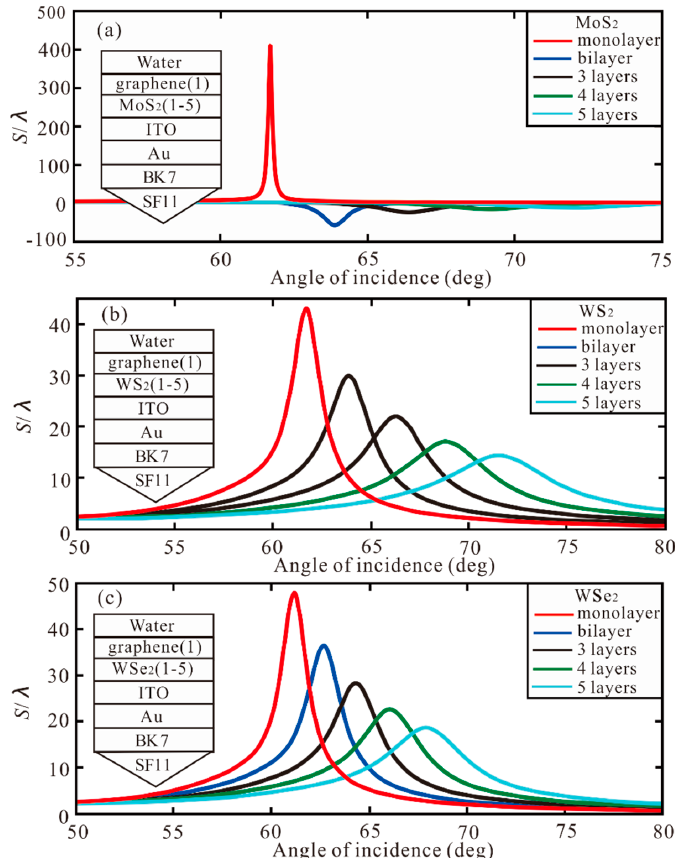
Figure 7. The GH shift with respect to angle of incidence with monolayer of graphene for different number of ( a ) MoS 2 layers, ( b ) WS 2 layers, ( c ) WSe 2 layers. number of ( a ) MoS 2 layers, ( b ) WS 2 layers, ( c ) WSe 2 layers.